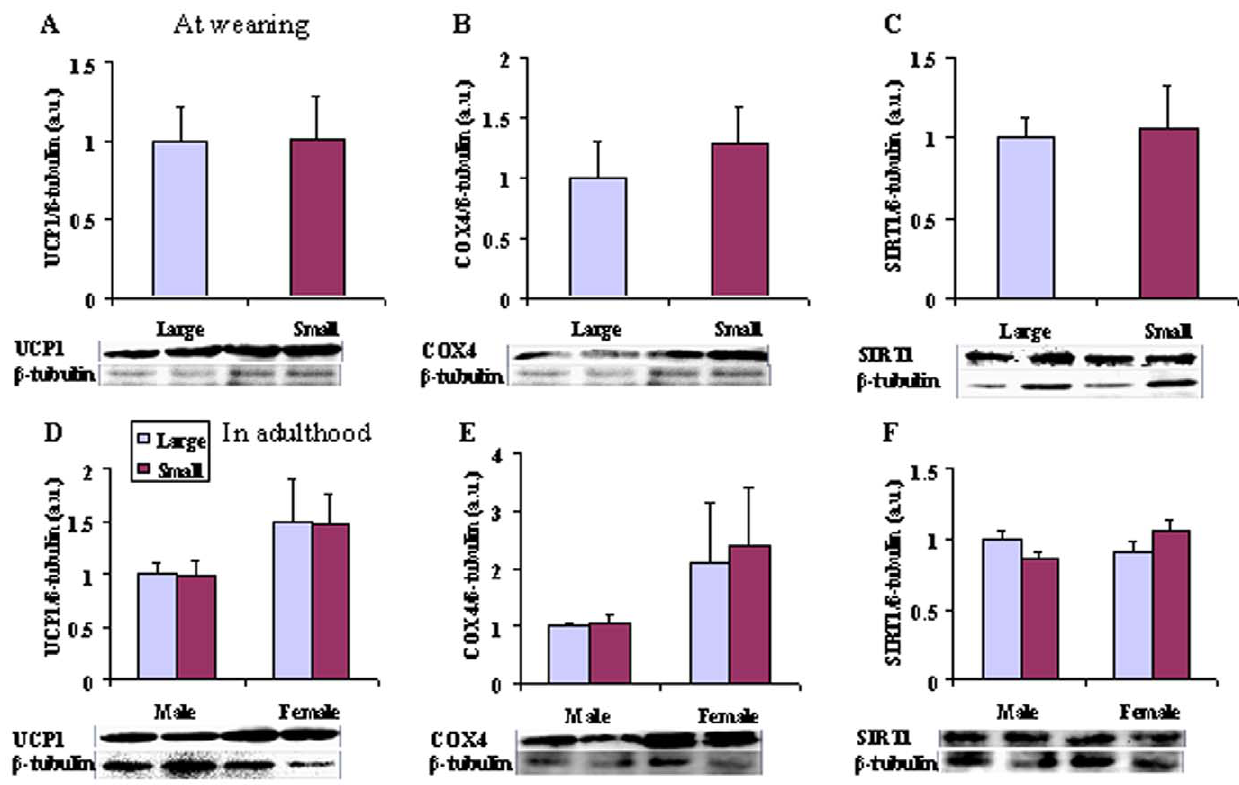
Figure 3. UCP1, COX4 and SIRT1 content in BAT at weaning (A–C) and in adulthood (D–F) in male and female voles from large and small litters. All these biomarkers in BAT were not affected by litter size, and the females showed more mRNA expression of UCP1 and COX4 in BAT than males. Values are presented as mean 6 SE. UCP1, uncoupling protein 1; COX4, cytochrome c oxidase 4; a.u., arbitrary unit.